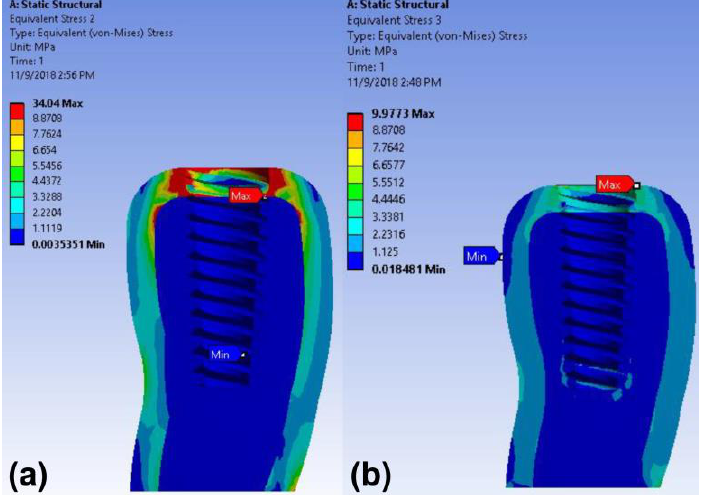
Figure 5. Color-coded von Mises stress distributions in the peri-implant bone under vertical load in the finite element model: ( a ) cement-retained and ( b ) cementless screw-retained zirconia crown models.